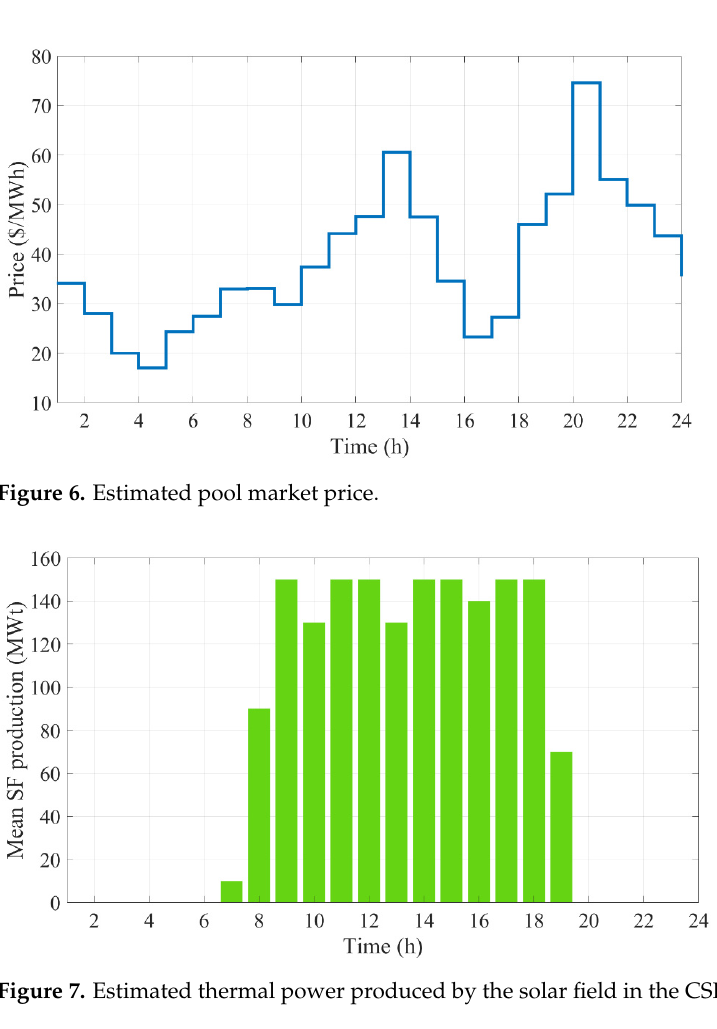
Figure 5. Estimated load profile.